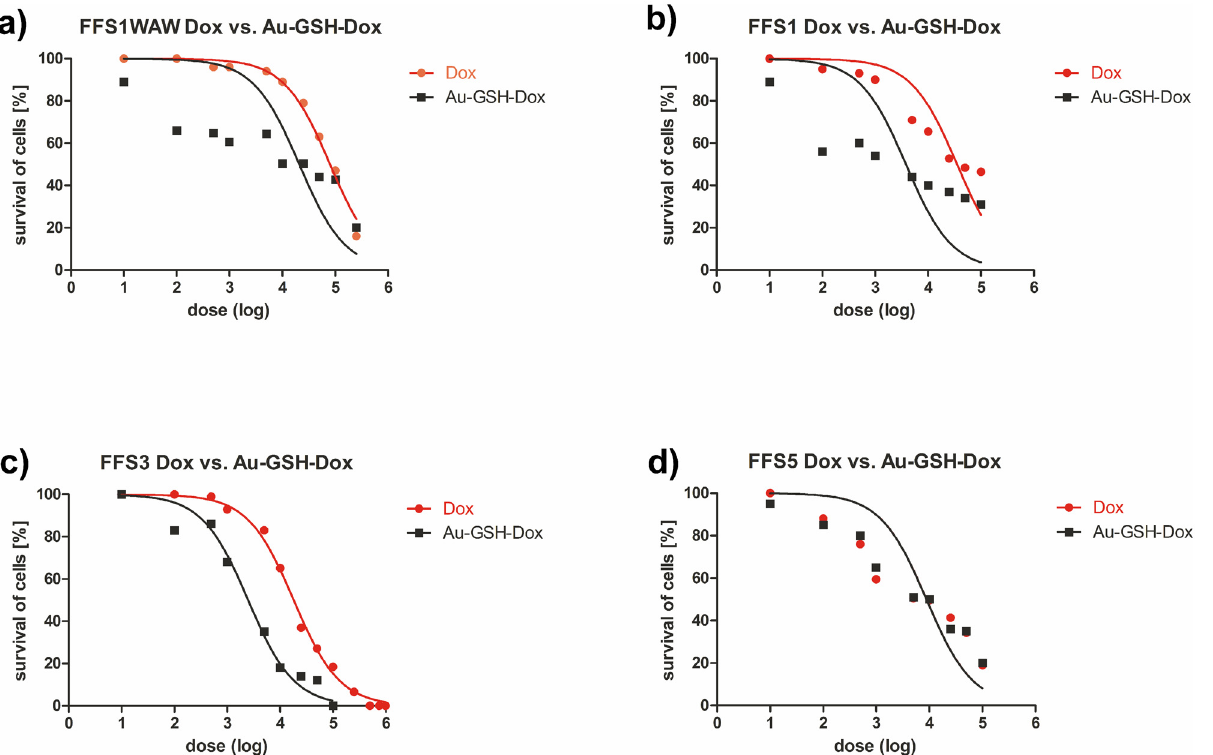
Fig 5. Correlation between cell viability (as measured with MTT assay) and chemotherapeutic dose. Analysis for (a) FFS1WAW, (b) FFS1, (c) FFS3 and (d) FFS5 cell lines. Red and black lines represent Dox and Au-GSH-Dox doses, respectively.